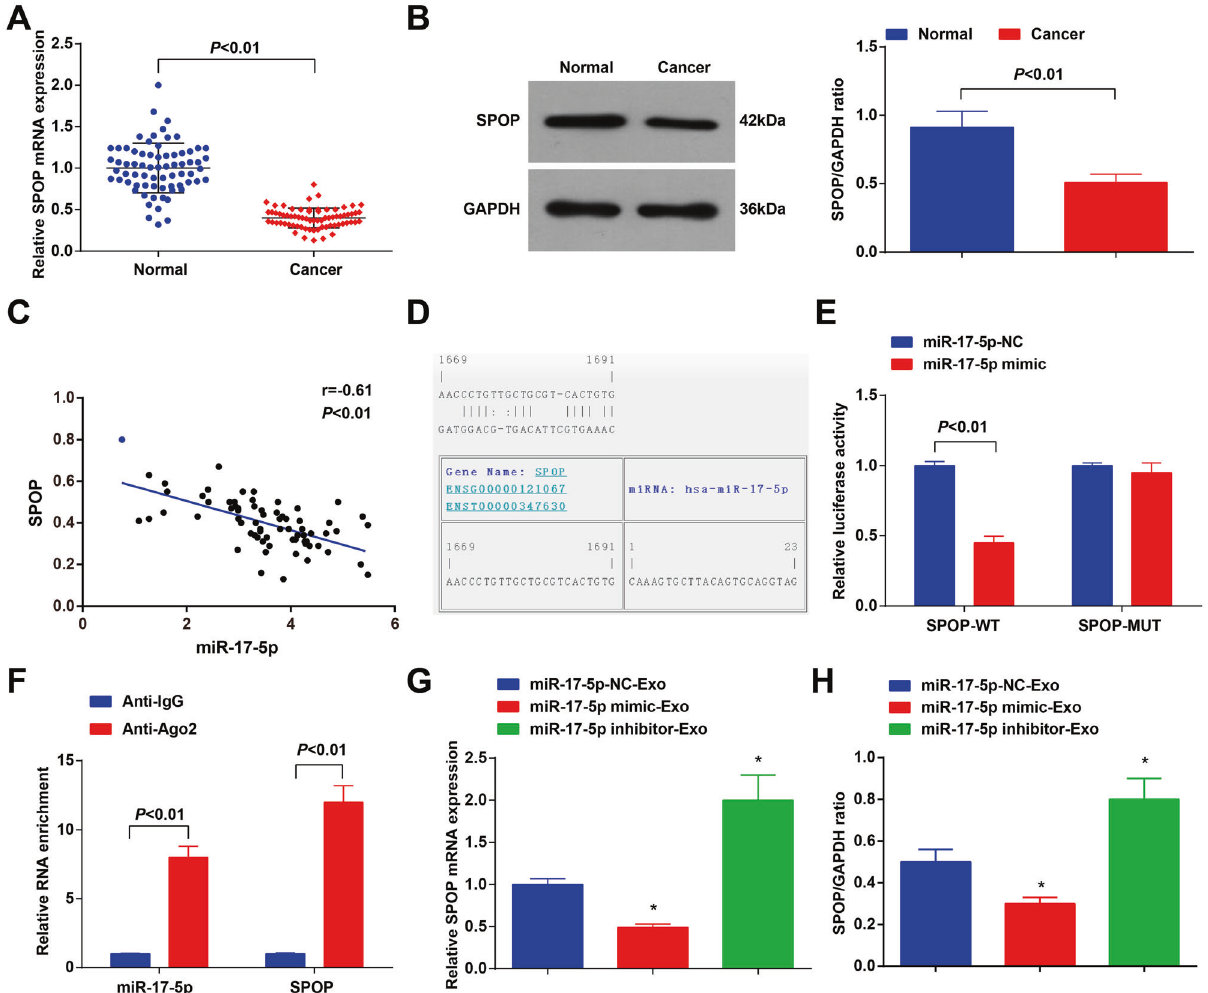
Fig. 6 MiR-17-5p targets SPOP. A SPOP expression in CRC tissues and adjacent normal tissues detected using RT-qPCR ( n = 70); B SPOP expression in CRC tissues and paracancerous tissues detected using western blot analysis ( n = 70); C correlation between expression of miR- 17-5p and SPOP analyzed using Pearson test ( n = 70); D binding sites between miR-17-5p and SPOP predicted at a bioinformatic website; E targeting relationship between miR-17-5p and SPOP con fi rmed using dual-luciferase reporter gene assay; F targeting relationship between miR-17-5p and SPOP con fi rmed using RIP assay; G SPOP expression in HCT116 cells detected using RT-qPCR and western blot analysis. Cell experiments were repeated three times; *P < 0.05 vs the miR-17-5p-NC-Exo group; the measurement data were expressed as mean ± standard